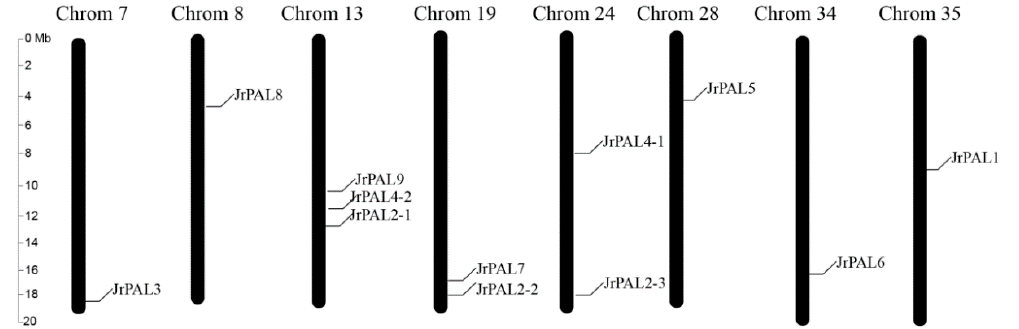
Figure 2. Chromosome locations of PAL genes of common walnut on 40 scaffolds (pseudo-chromosomes). The pseudo-chromosome name is at the top of each bar. The scale of the pseudo-chromosomes is millions of base pairs (Mb).